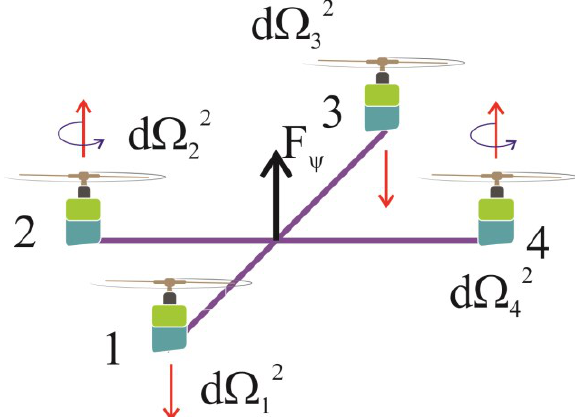
Fig. 8. Gyroscopic effect on the Y axis (angle θ